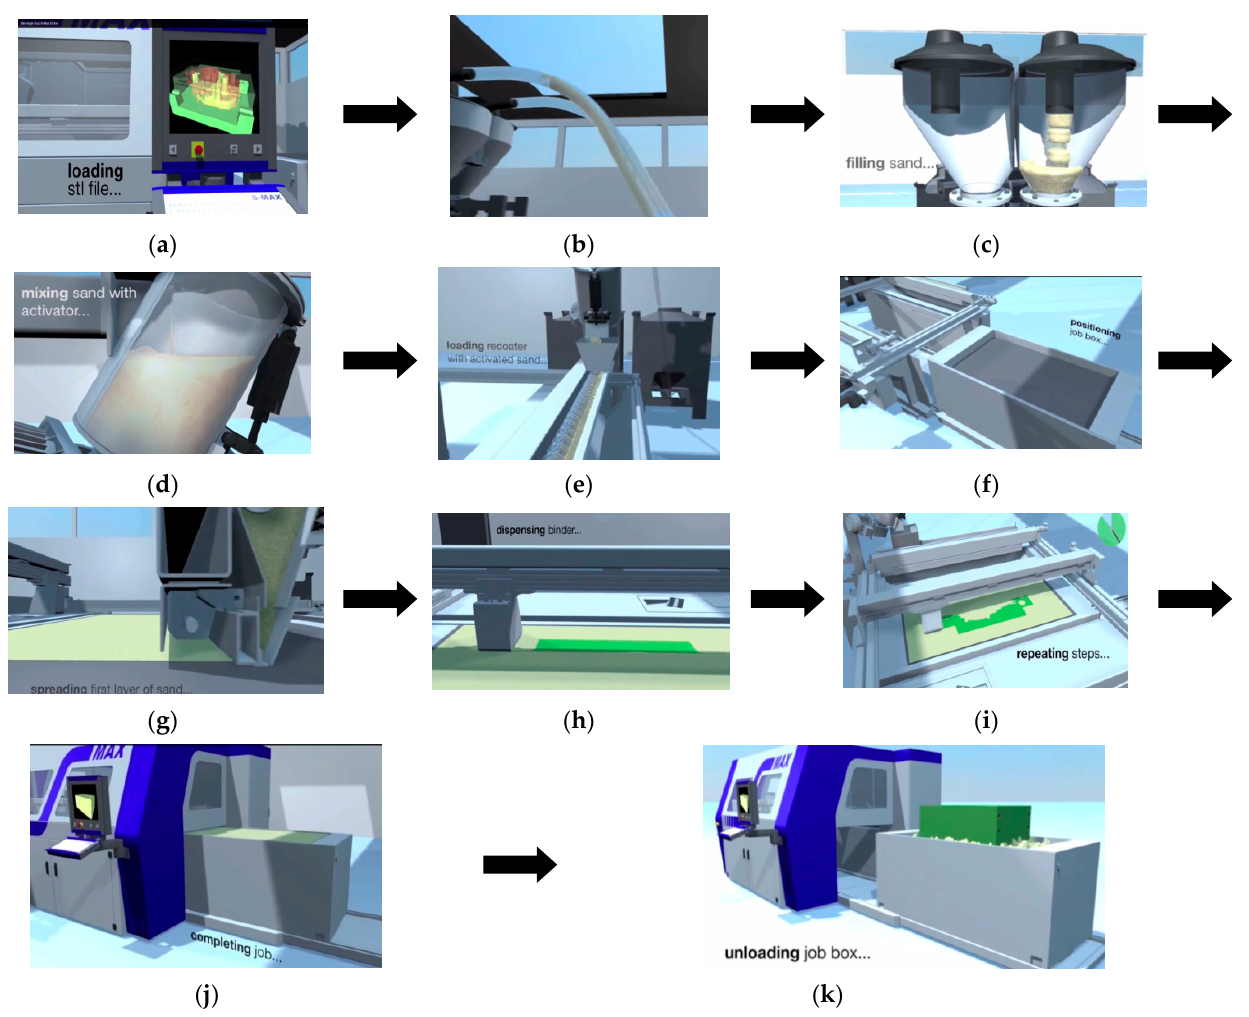
Figure 3. Stages of making ceramic molds by 3D printing: ( a ) Importing the “stl” model in the Rapix3D program; ( b ) Suppling sand from machine bunkers; ( c ) Loading with sand the small bunkers above the machine; ( d ) Mixing the sand with the activator in the machine mixer; ( e ) Transport of the mixture through the injecting screw; ( f ) Positioning the machine table in the workspace; ( g ) Laying the first layer of ceramic material; ( h ) Binder dispersion; ( i ) Repeating Steps 7 and 8; ( j ) Ending the manufacturing process of ceramic parts; ( k ) Removing parts from the workspace.